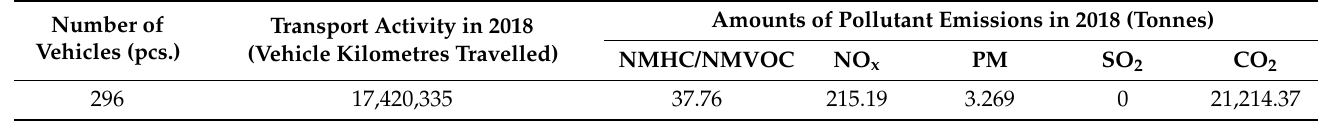
Table 1. Amounts of pollutant emissions generated by public bus fleet in Szczecin in 2018. Number of Vehicles (pcs.)